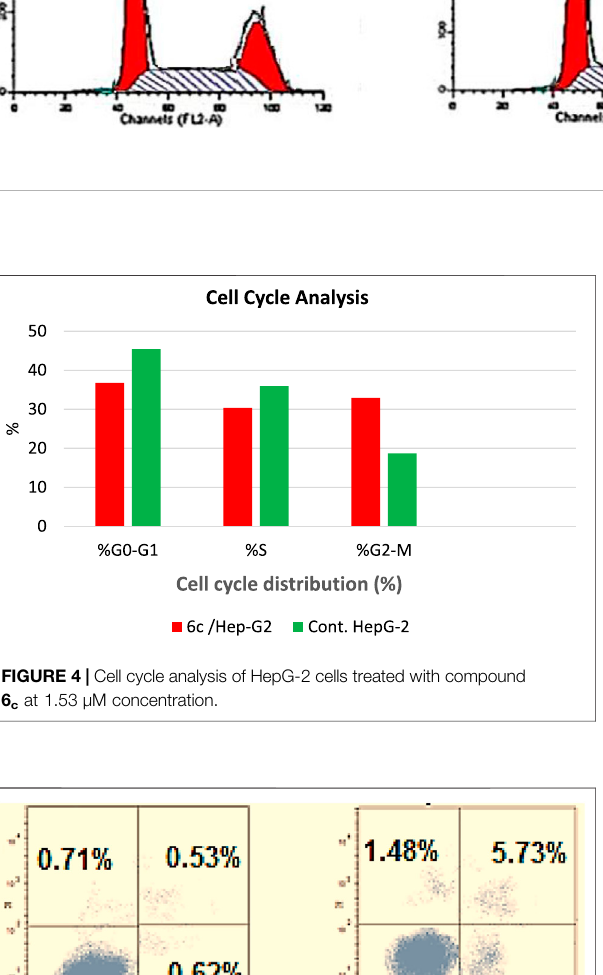
Frontiers in Chemistry |